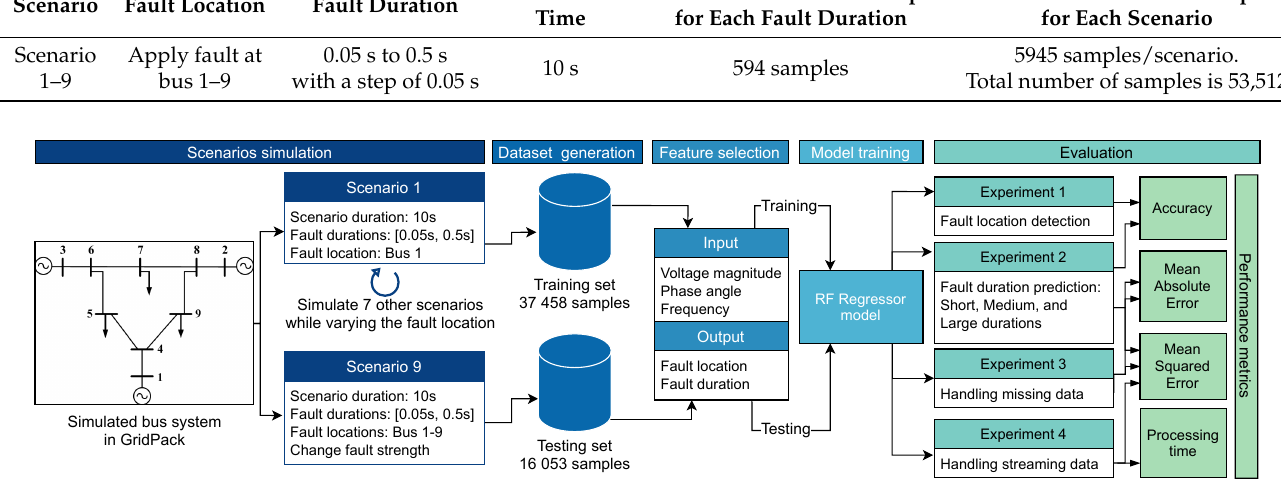
Figure 3. Conceptual diagram of the proposed